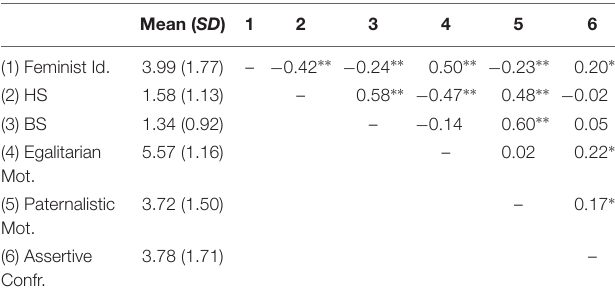
TABLE 1 | Means, standard deviations, and correlations for Study